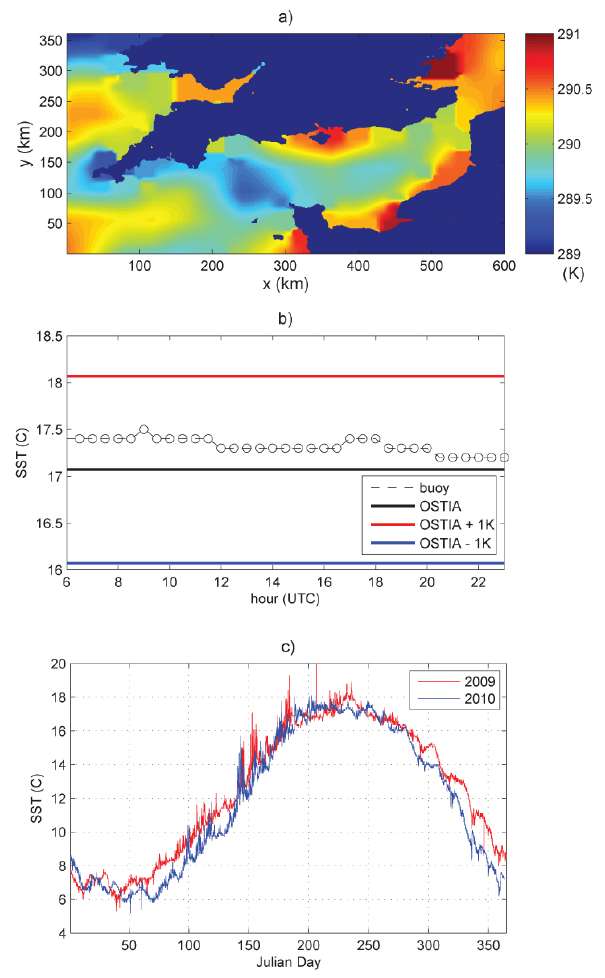
Fig. 3. (a) Met Office surface analysis valid at 00:00UTC on 8 August 2010. (b) Visible satellite image over southern UK at 15:00UTC on 8 August 2010. The yellow box in panel (b) cor- responds to a subdomain of the MetUM simulations run with 1km grid length that are presented in Sects. 4 and 5. Images courtesy of the Met Office (Crown